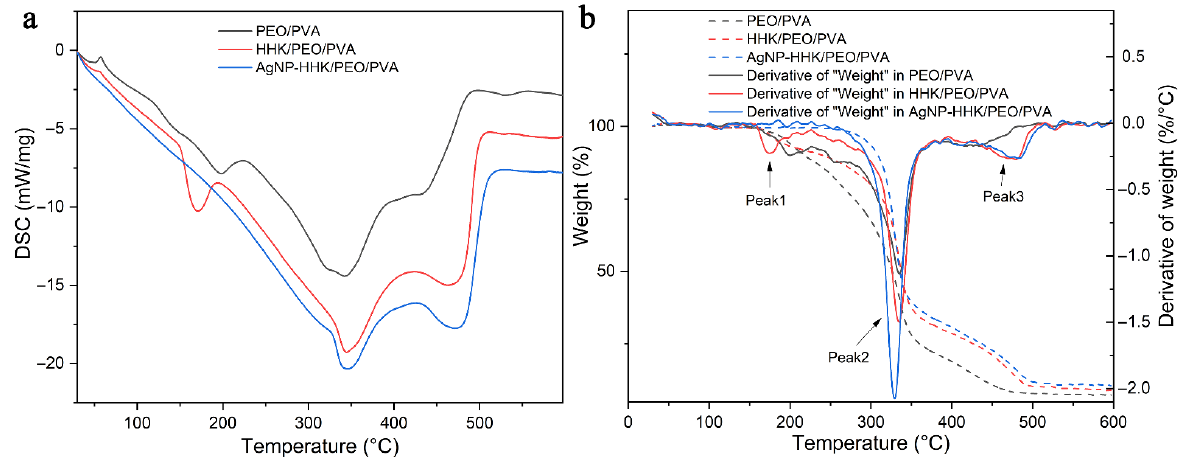
Table 2. DSC and TGA data of the (a) PEO/PVA, (b) HHK/PEO/PVA and (c) AgNP-HHK/PEO/PVA nanofibrous mats.